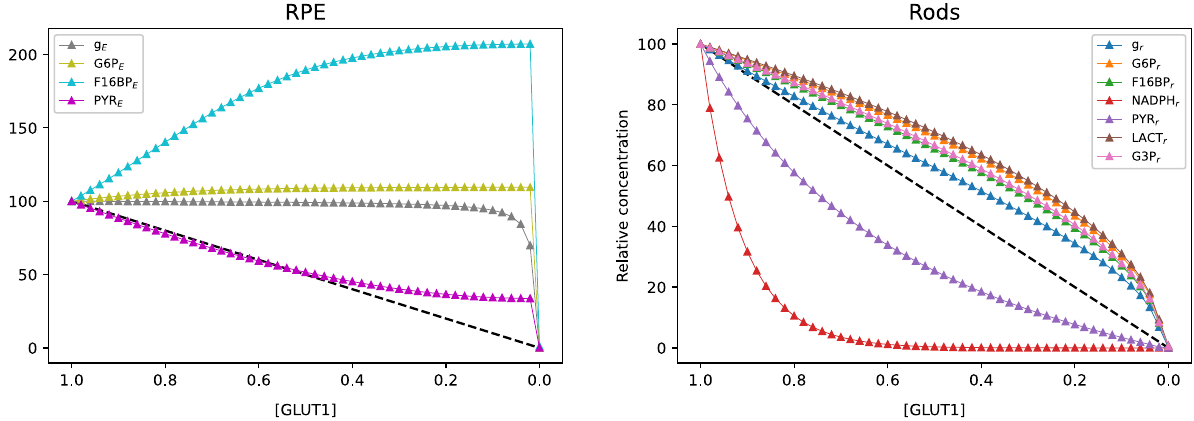
Figure 7. Relative steady state concentrations of all metabolites in the RPE and the rods as [GLUT1] decreases from 1 to 0, with all metabolites scaled to 100 at GLUT1 = 1 (representing the healthy case). Left panel: Metabolite concentrations in the RPE. The glucose concentration in the RPE (gray curve) stays close to its healthy value up until [GLUT1] has decreased by approximately 80% , i.e., [GLUT] = 0.2, likely due to the regulating mechanisms that block the glucose passage to the rods. There is a slight increase in the G6P and significant increase in the F16BP. Initially, the pyruvate concentration decreases at an almost constant rate because it highly depends on the rods’ contribution of lactate, which is lower with every step. However, when [GLUT1] decreases from approximately 0.45 down to 0.2, the rate at which pyruvate decreases and the rate at which F16BP increases both slow down. As [GLUT1] becomes even scarcer ([GLUT1] less than approximately 0.2), the glucose concentration decays rapidly. Right panel: Metabolite concentrations in the rods. The RPE’s regulating mechanisms block the passage of glucose to the rods, making its concentration decrease with every step. As [GLUT1] decreases, the production of aerobic glycolysis intermediate products is favored (slowest overall decrease). Among these are the production of G3P by the KP (essential for the rods’ OS renewal) and the production of lactate (that contributes to the RPE’s survival); the others are G6P and F16BP. Meanwhile, the production of NADPH (by the PPP, and the metabolite that undergoes the most rapid decrease) and pyruvate (that fuels the rods’ OXPHO) are the most affected by the response of the regulating mechanisms to the [GLUT1] decrease and the consequential glucose shortage. When [GLUT1] is less than approximately 0.2, the glucose directed to the rods is too small to maintain any of its functions, and all the metabolites concentrations rapidly go to